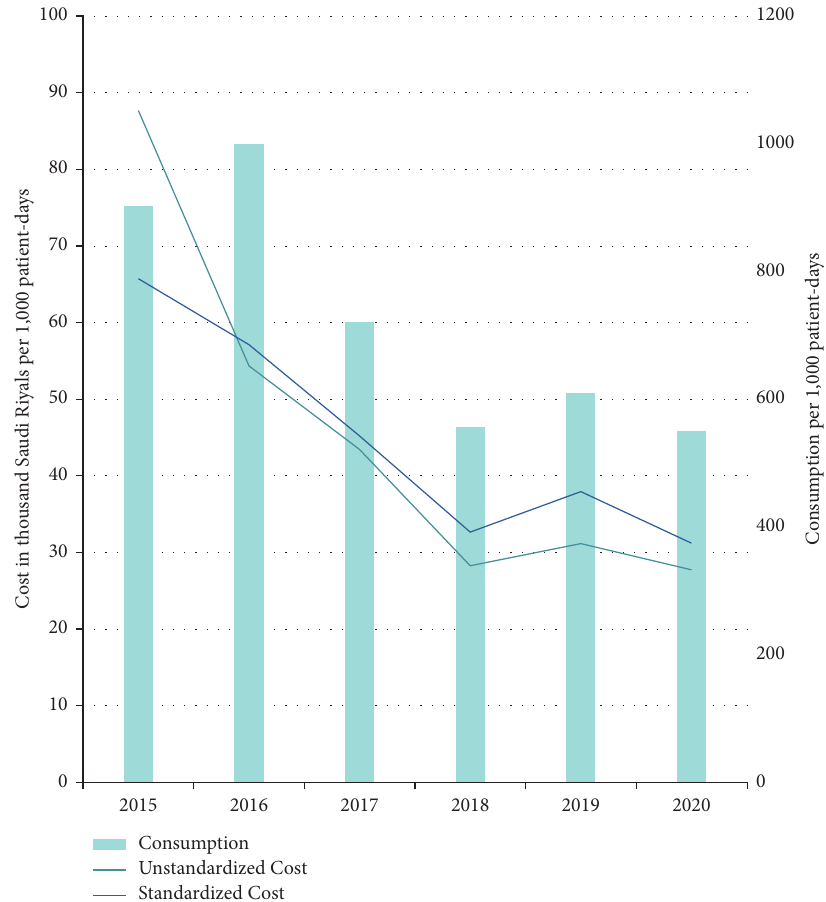
Figure 2: Consumption and cost of restricted injectable antimicrobials per 1,000 patient days, following the implementation of the antimicrobial stewardship program. Standardized costs are calculated by multiplying the actual consumption by the mean prices for each antimicrobial agent. It was used to adjust for the significant variance in cost due to the significant variability of antimicrobials’ prices across the